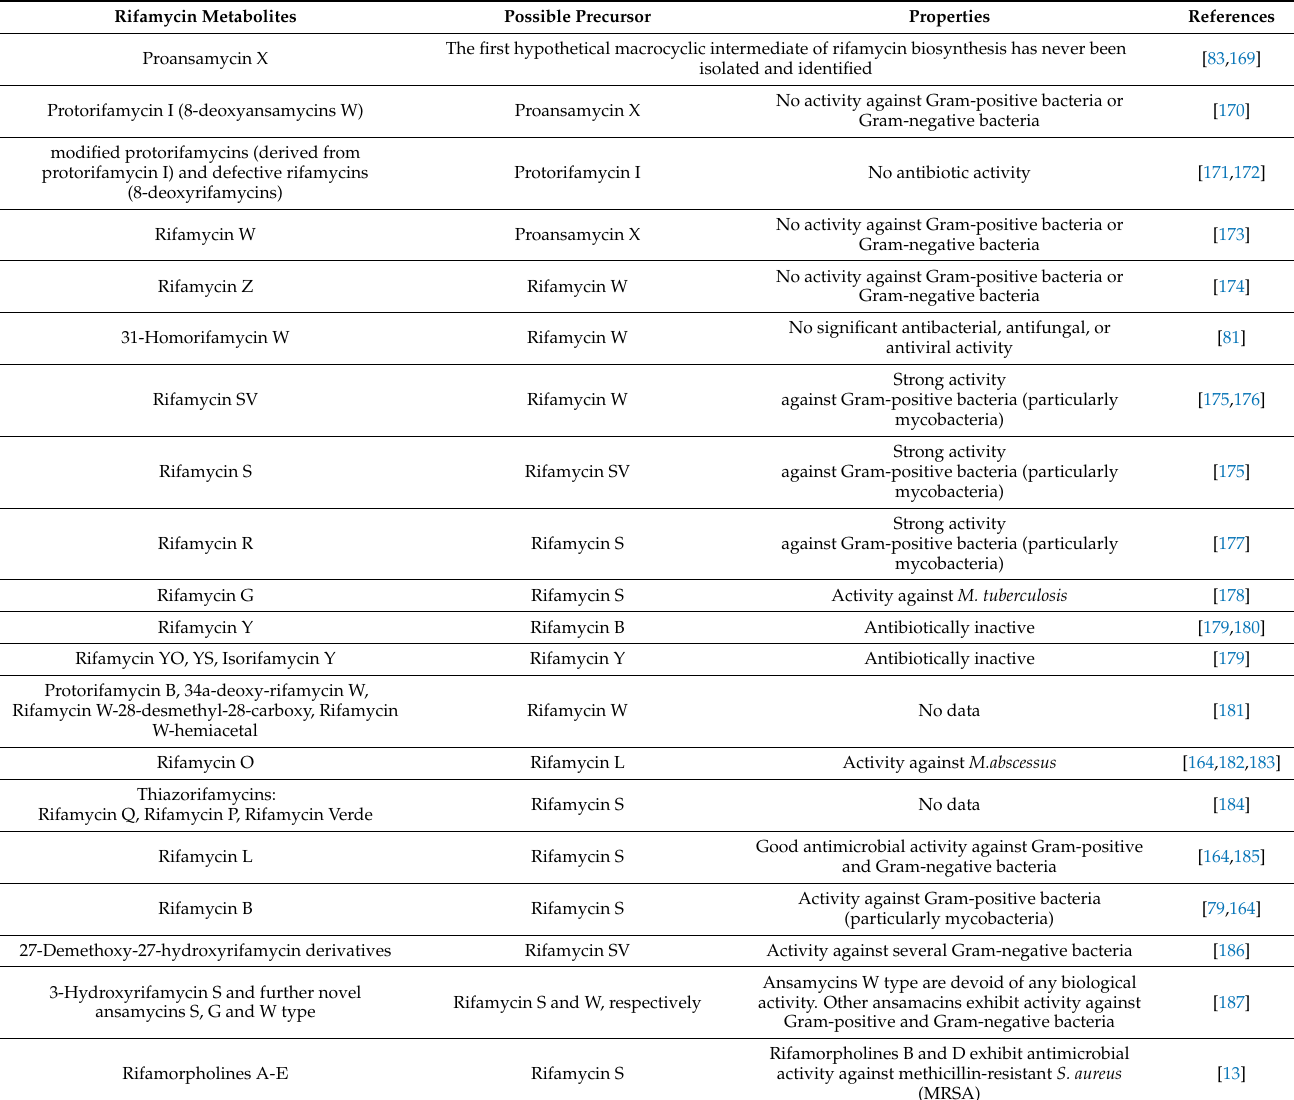
Table 3. Rifamycins and related metabolites produced by actinobacteria of the genus Amycolatopsis